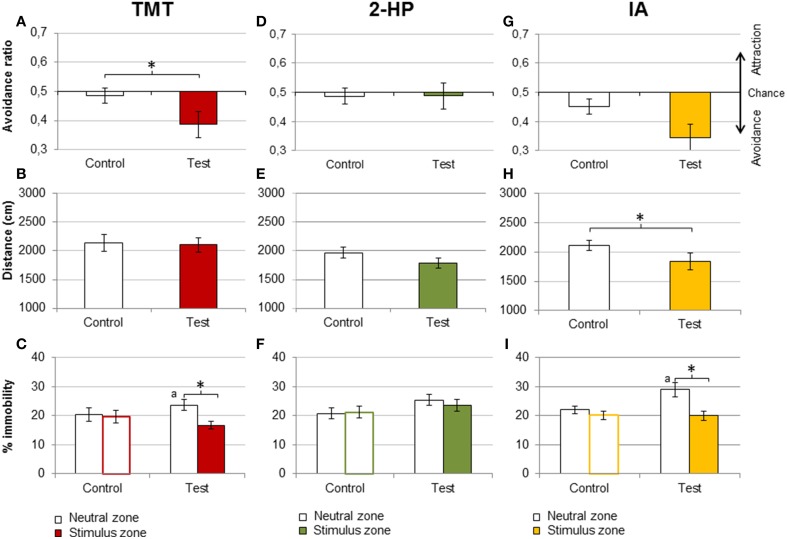
TMT and IA, but not 2-HP, induced contextual learning. Bar charts representing behavioral responses in the contextual learning experiment, in the pre-exposure control (Control) and the contextual memory test (Test). Mice exposed to pure TMT during four consecutive sessions expressed conditioned place avoidance to the zone paired with the stimulus, as shown by a significant decrease of the avoidance ratio in the test (A). In addition, TMT failed to affect distance traveled (B), but increased immobility in the neutral zone during the test (C), suggesting that animals avoided TMT and stayed immobile in the neutral zone. By contrast, 2-HP did not induce a contextual memory, since it did not affect the avoidance ratio (D), but, overall, it slightly decreased distance traveled (E), and did not affect immobility (F). Finally, IA produced a marginally significant decrease in the avoidance ratio (G), and significantly decreased distance traveled (H). Like TMT, IA increased immobility in the neutral zone (I). *p < 0.05. Comparison between the neutral zones in control and test: a, p < 0.05. Data are expressed as mean ± SEM.